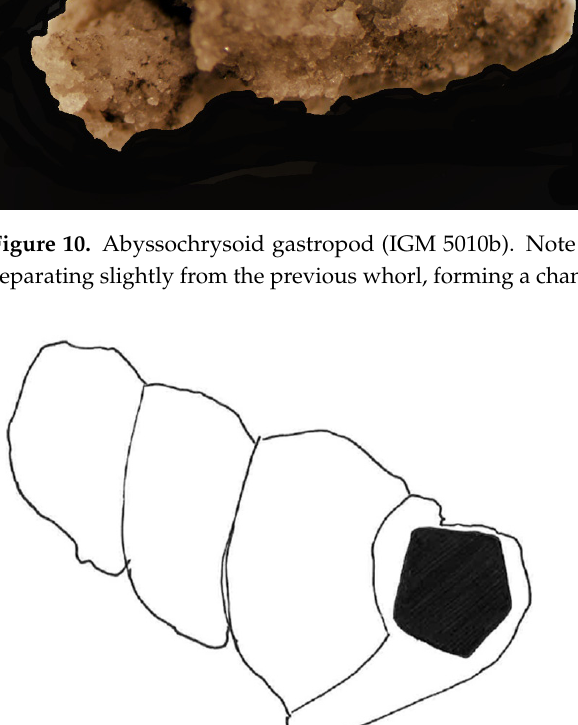
Figure 11. Abyssochrysoid gastropod (IGM 5010b). Line art sketch showing polygonal aperture.